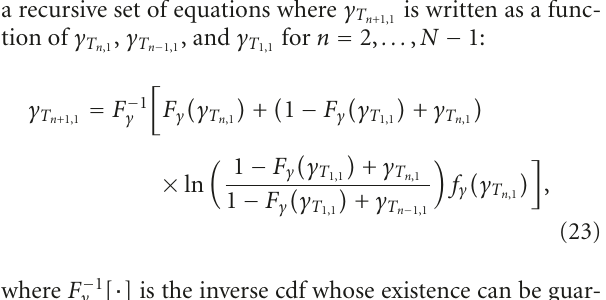
Figure 3: Switching thresholds { γ T age pre-adaptation SNR. For each data series, the lowermost curve , while the uppermost shows γ T shows γ T 1,1